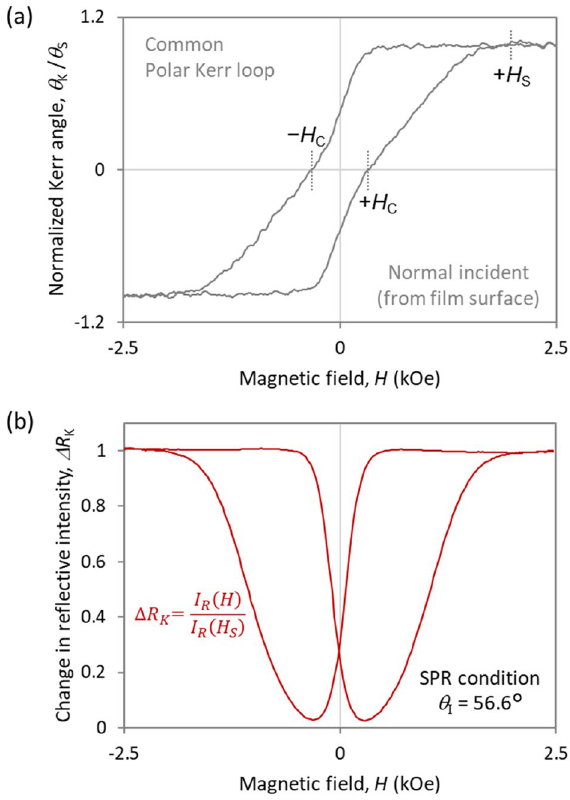
Figure 3. ( a ) MO hysteresis loop and ( b ) reflected intensity as a function of external magnetic field for Al 2 O 3 / CoPt/AZO trilayer shown in Fig. 2. ( b ). Both loops are normalized by each value in the magnetically saturated state. The MO loop was measured under the common polar Kerr configuration in which the incident radiation is normal to the sample surface. The change in reflective intensity was measured under SPR